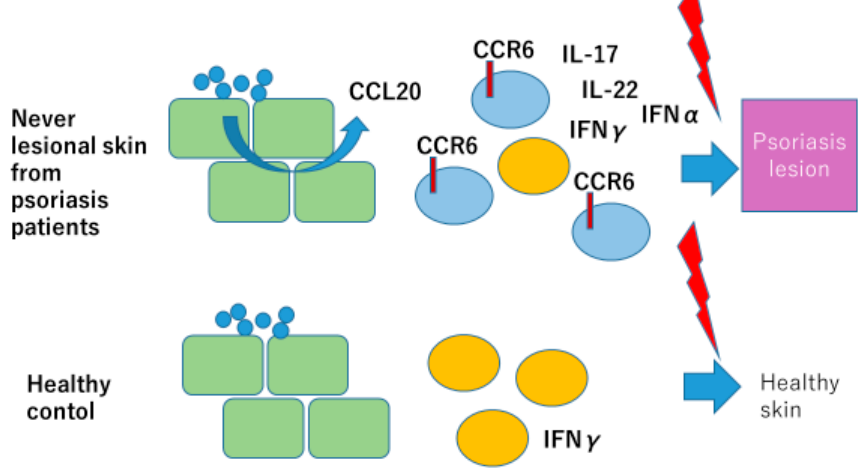
Figure 2. Skewed balance of tissue resident immune cells induces psoriasis in never-lesional skin of psoriasis patients. Modified from Gallais Sérézal I et al. J Allergy Clin Immunol 2018 [17]. Weak stimulation by commensal bacteria and fungi causes sparse production of CCL20 from the epidermal keratinocytes, resulting in skewed distribution of CCR6-positive, IL-17-producing cells in the never-lesional skin of psoriasis patients (NLP) over IFN γ -producing cells, which prepare